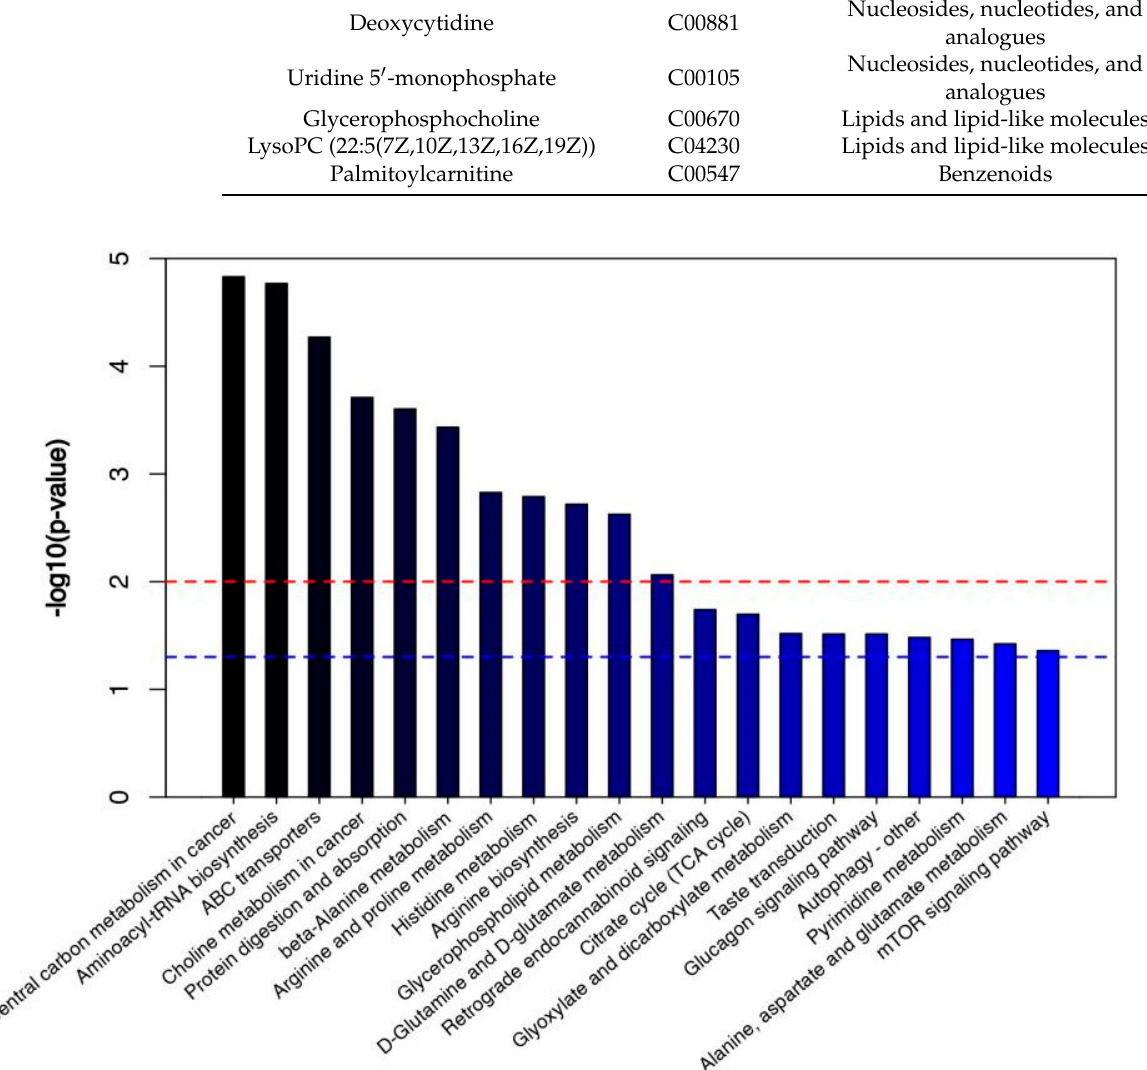
Figure 6. Metabolic pathway enrichment map (Top 20). The columns higher than the blue line mean p < 0.05, and the columns higher than the red line mean p < 0.01.